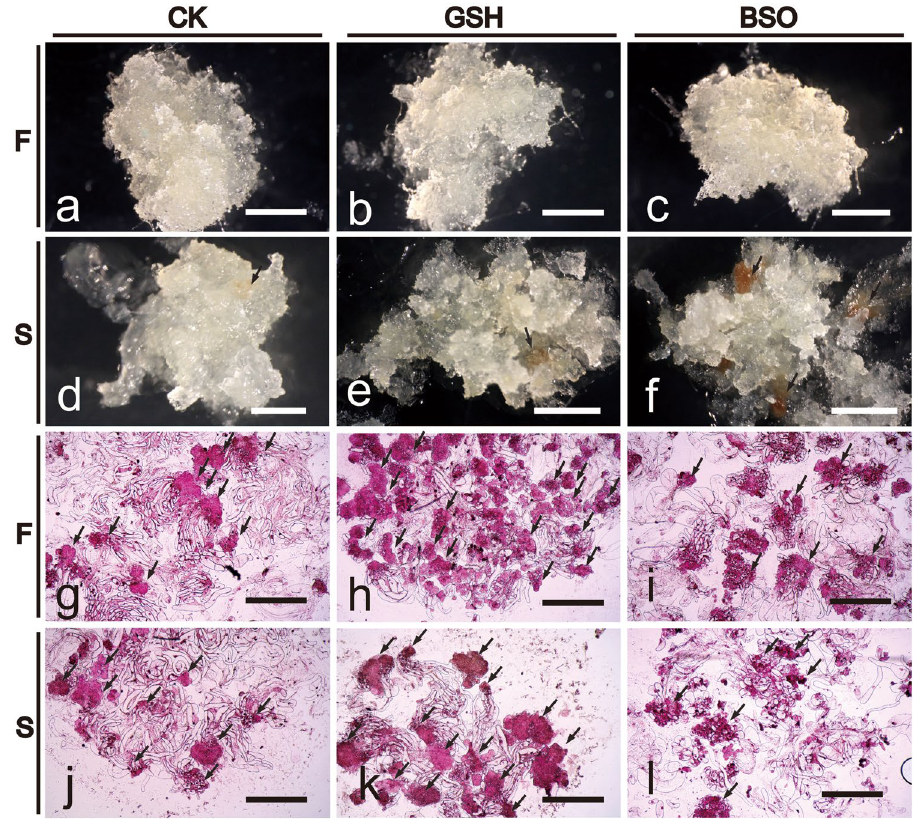
Figure 1. Effects of exogenous GSH and BSO on EC cell morphology of two Korean pine cell lines. ( a ) F-CK treatment; ( b ) F-GSH treatment; ( c ) F-BSO treatment; ( d ) S-CK treatment; ( e ) S-GSH treatment; ( f ) S-BSO treatment. ( a – f ) bars = 1 cm. ( g ) F-CK internal structure; ( h ) F-GSH internal structure; ( i ) F-BSO internal structure; ( j ) S-CK internal structure; ( k ) S-GSH internal structure; ( l ) S-BSO internal structure. ( g – h ) bars = 200